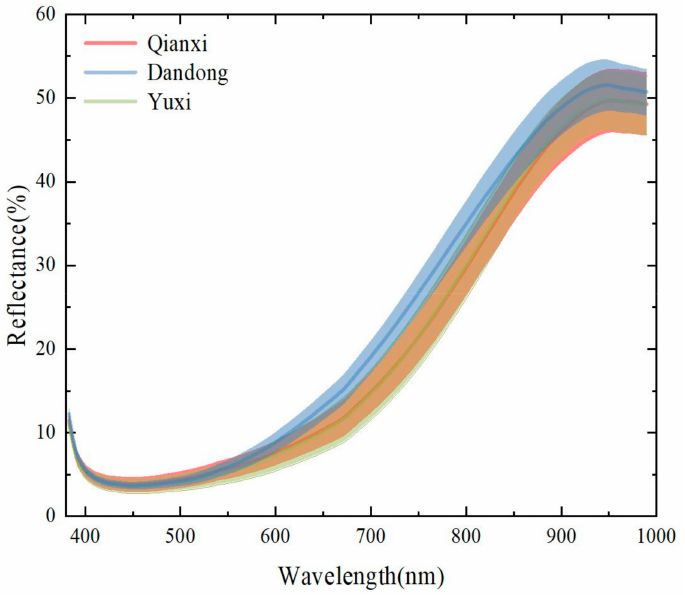
Figure 3. Average reflectance spectra with standard deviation (SD) of three different origins of